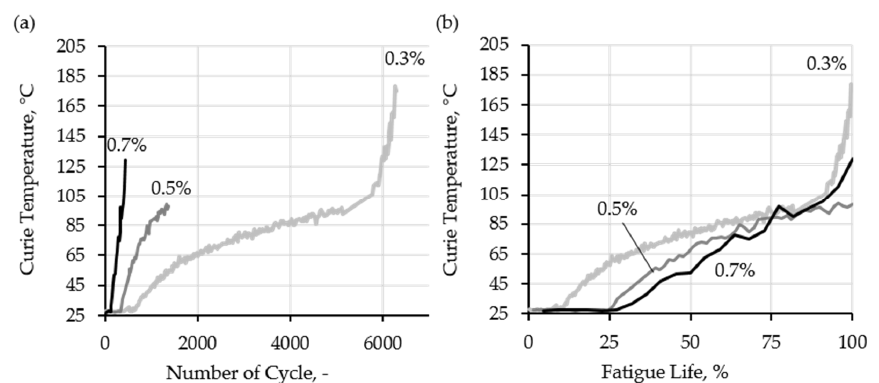
Figure 7. Evolution of Curie temperature in the fatigue tests with different strain amplitudes as a function of ( a ) the number of cycles and ( b ) normalized fatigue life; recompiled from ref. [19]. In addition to the Curie temperatures, the amplitudes of the third harmonic curves at 25 °C were evaluated. As the Curie temperature reflects a different part of the data ently.